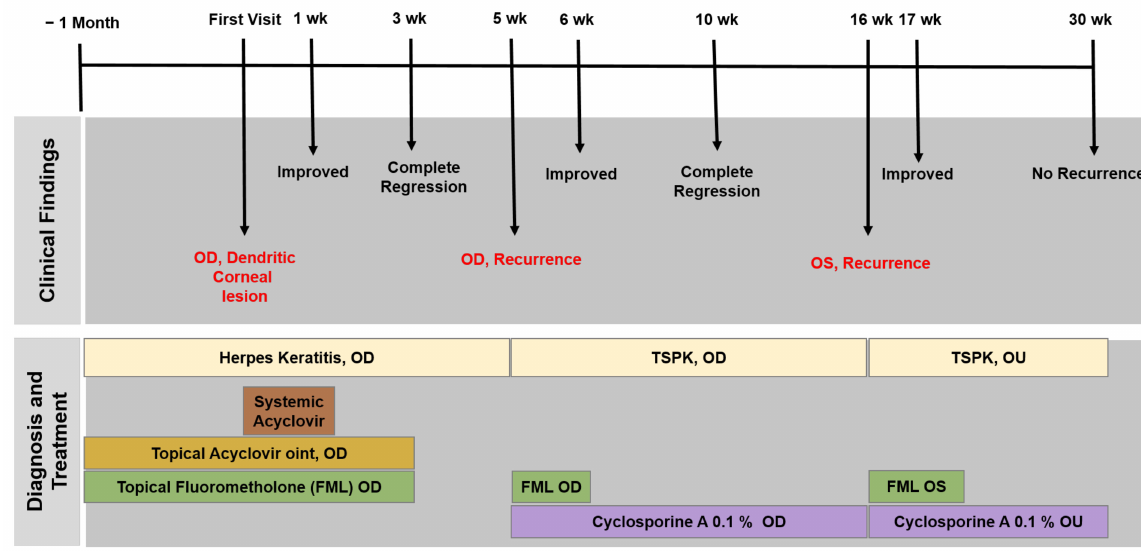
Figure 3. Timeline of the reported